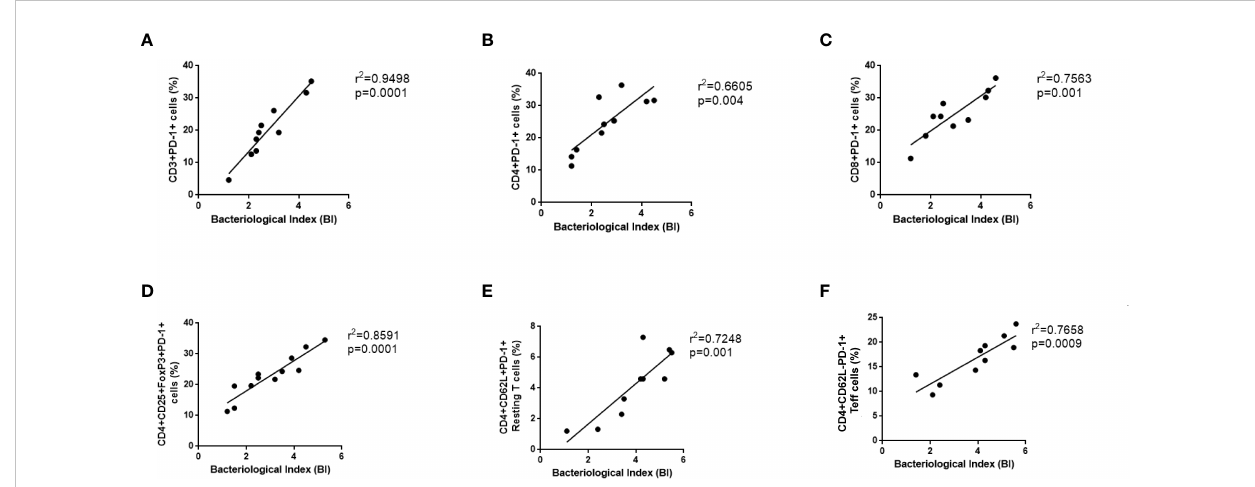
FIGURE 5 Positive Correlation between PD-1 expressing various T cells and bacteriological index (BI) in Leprosy. PD-1 expression on various T cells (A) CD3 +PD-1+ (B) T helper cells (CD4+PD-1+) (C) T cytotoxic cells (CD8+PD-1+), (D) T regulatory cells (CD4+CD25+FoxP3+PD-1+) (E) T effector cells (CD3+PD-1+CD62L-), (F) Resting T cells (CD3+PD-1+CD62L+) positively correlates with bacteriological index (BI) in leprosy patients (n = 10). Correlation was done using Spearman ’ s rank correlation coef fi